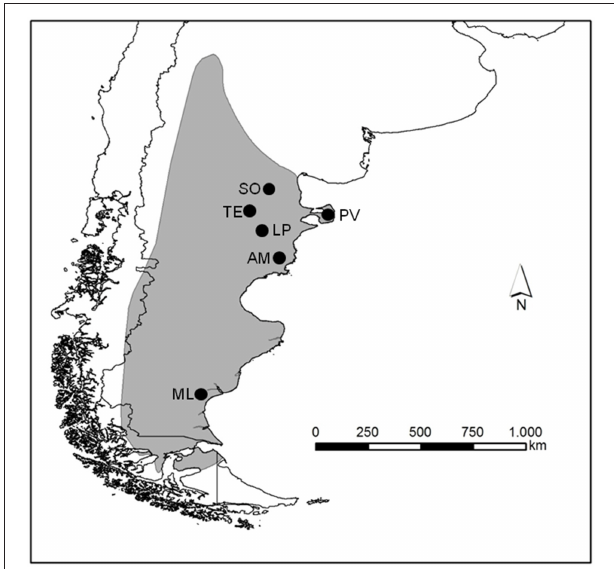
FIGURE 1 | Distributional range of Rhea pennata pennata (gray area) in South America and location of the study sites (black circles do not represent areas but indicate the sites where transects were